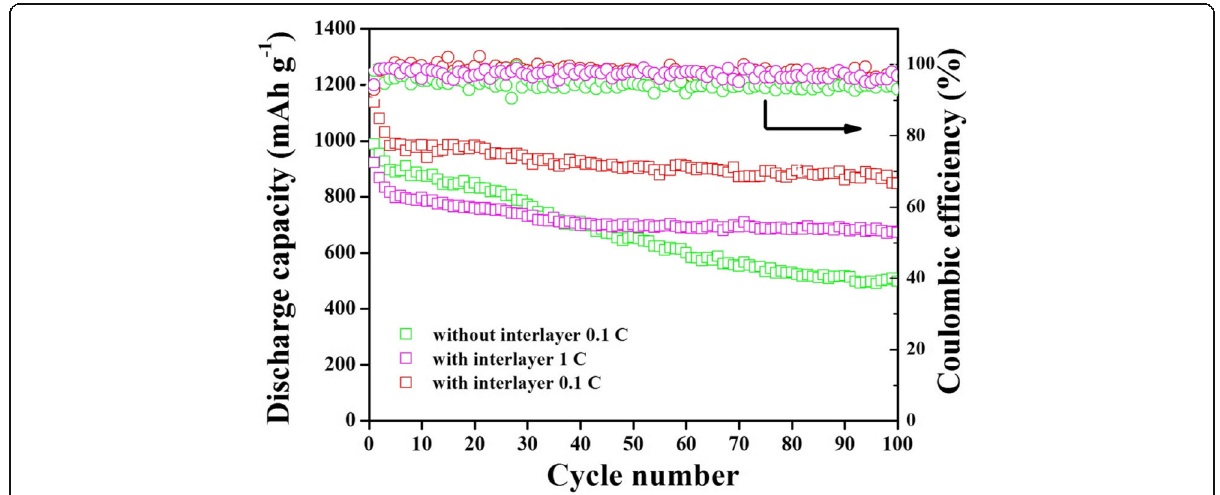
Fig. 5 Cycling performance and coulombic efficiency of cells assembled with and without CeO 2 /RGO composite coated separator